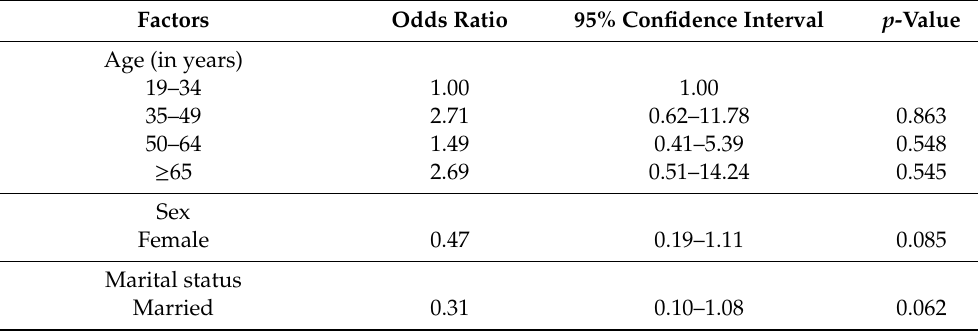
Table 4. Factors associated with unmet healthcare needs